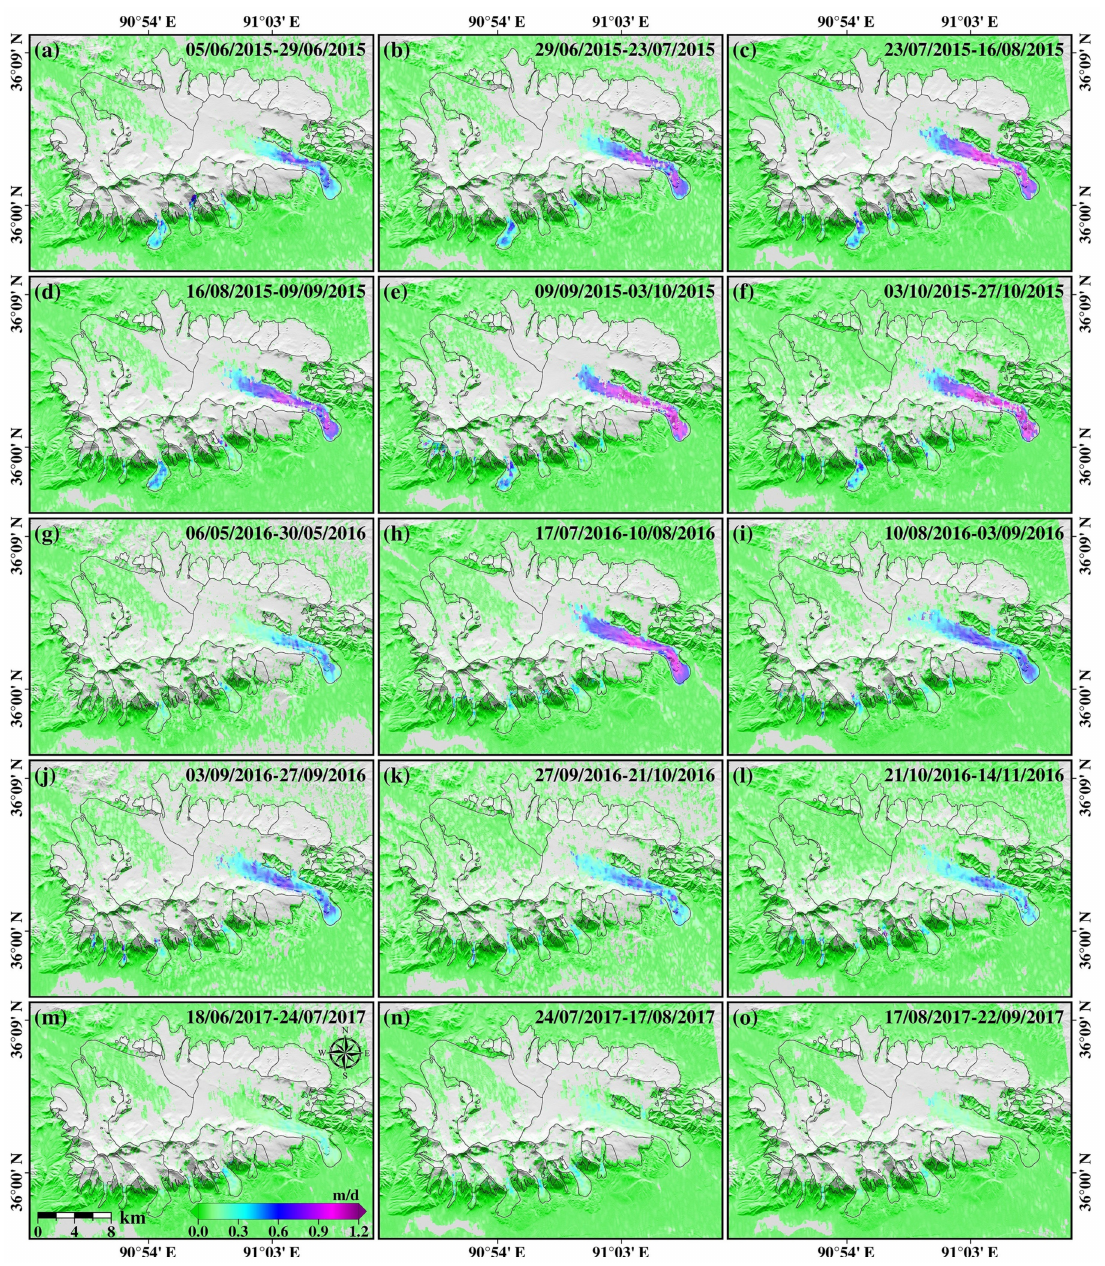
Figure 3. Two-dimensional surface flow velocities of the Bukatage glacial center from 2015 to 2017. Black lines: glacier outlines; backgrounds: shaded